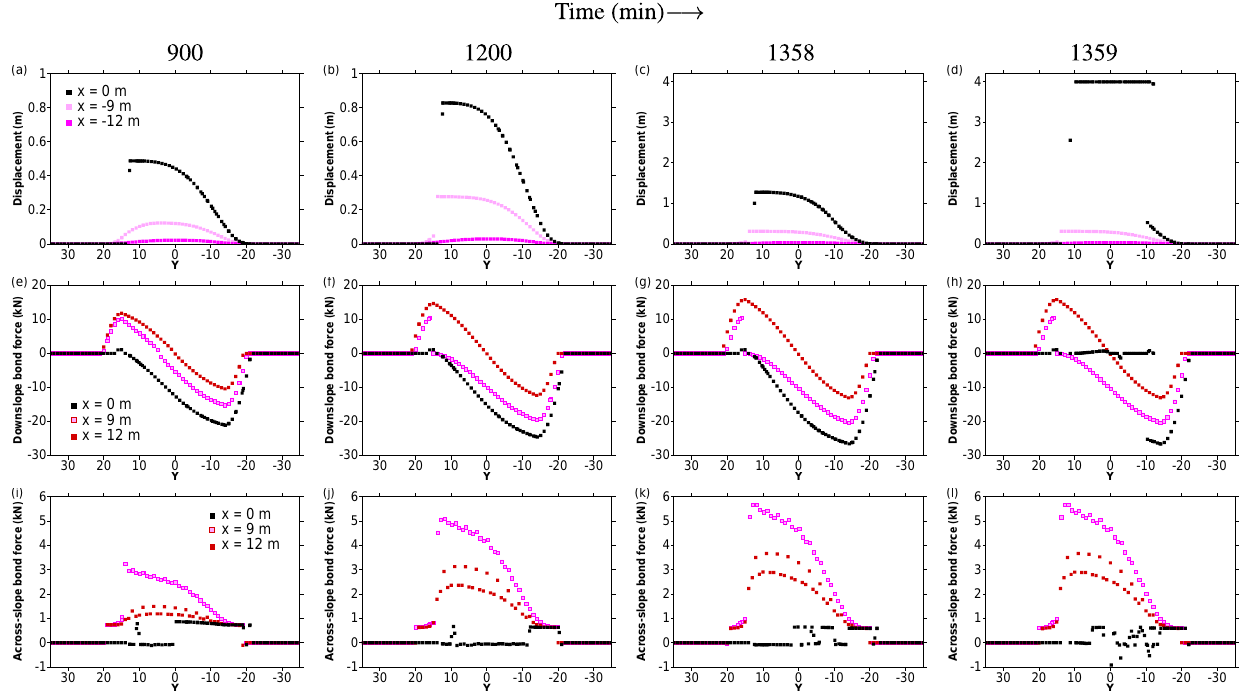
Figure 7. Time evolution of (a–d) displacement, (e–h) downslope bond force, and (i–l) across-slope bond force along three downslope cross sections at different distances from the center line (0, − 9, and − 12m; see Fig. 6) at four different times. Note the different scale for displacement in panels (c) and (d)